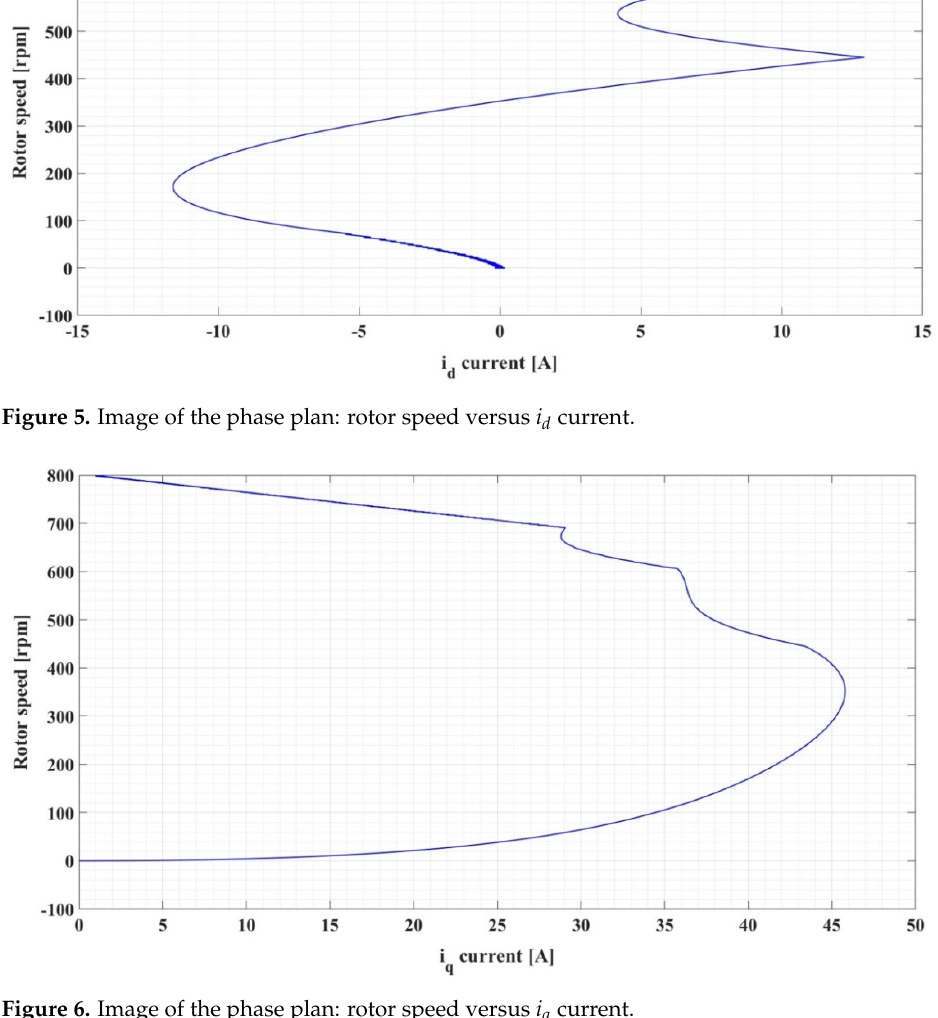
Figure 6. Image of the phase plan: rotor speed versus i q current.